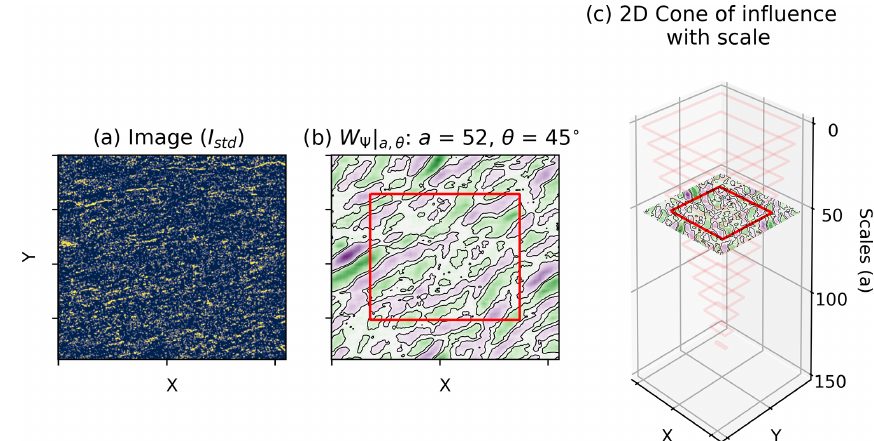
Figure A4. Defining the limits of the analysis across scales. For some image (a) , an arbitrary wavelet transformation is visualised at an arbitrary scale and angle (b) . Here, the black contours enclose data that are within the 95% confidence level. Overlaying this is a red contour that delimits the zone of possible edge effects of the analysis. At this scale, this is a slice of the cone of influence (COI). Panel (c) visualises the COI across scales. As the scale, and therefore the wavelength, of the analysing wavelet increases, the zone without edge effects decreases. For the purposes of demonstration, data within the COI have not been removed in this figure.